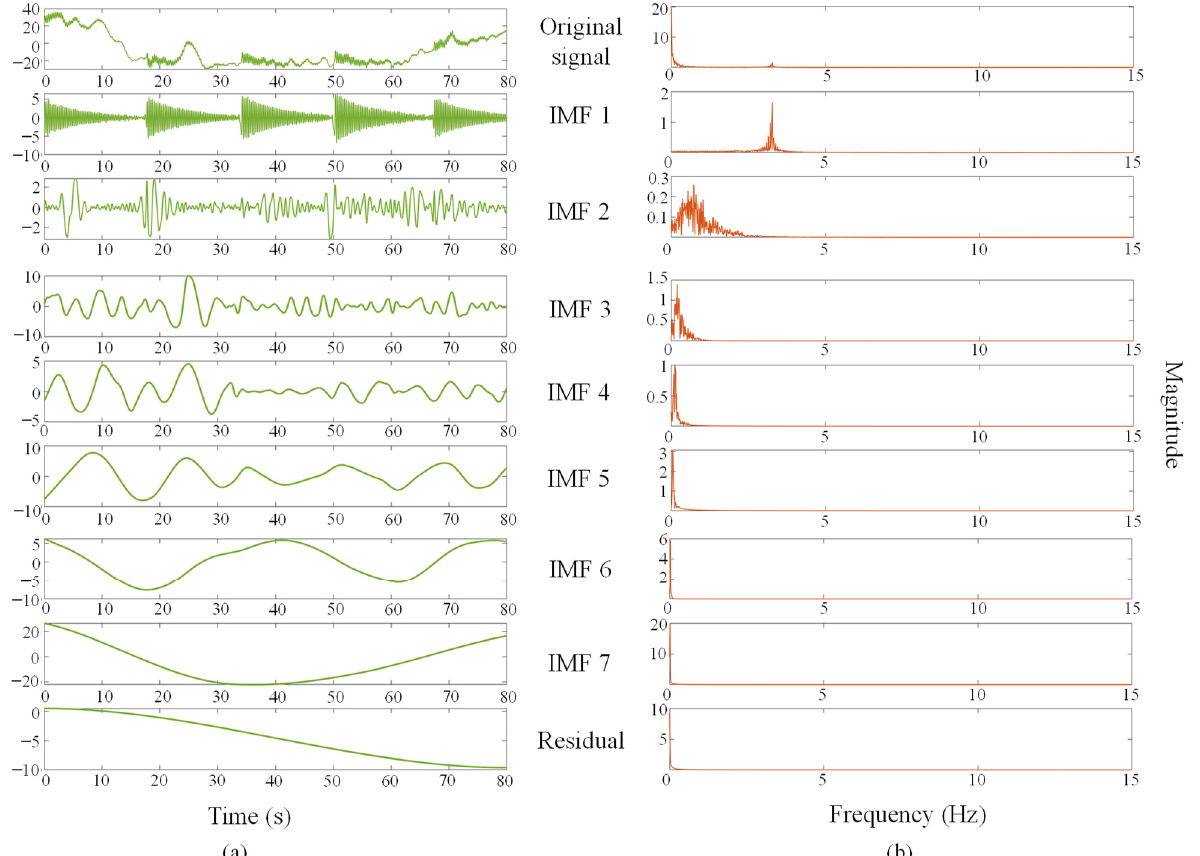
Figure 13. Original signal, IMF 1 and composite signal. Since the signal measured by the UAV and corrected by DF is an acceleration signal, in order to facilitate comparison, the displacement signal measured by the fixed camera and the UAV displacement signal corrected by EMD and FT are processed by the second- order differential filtering, as shown in Figure 14. It shows that the curves of four cases